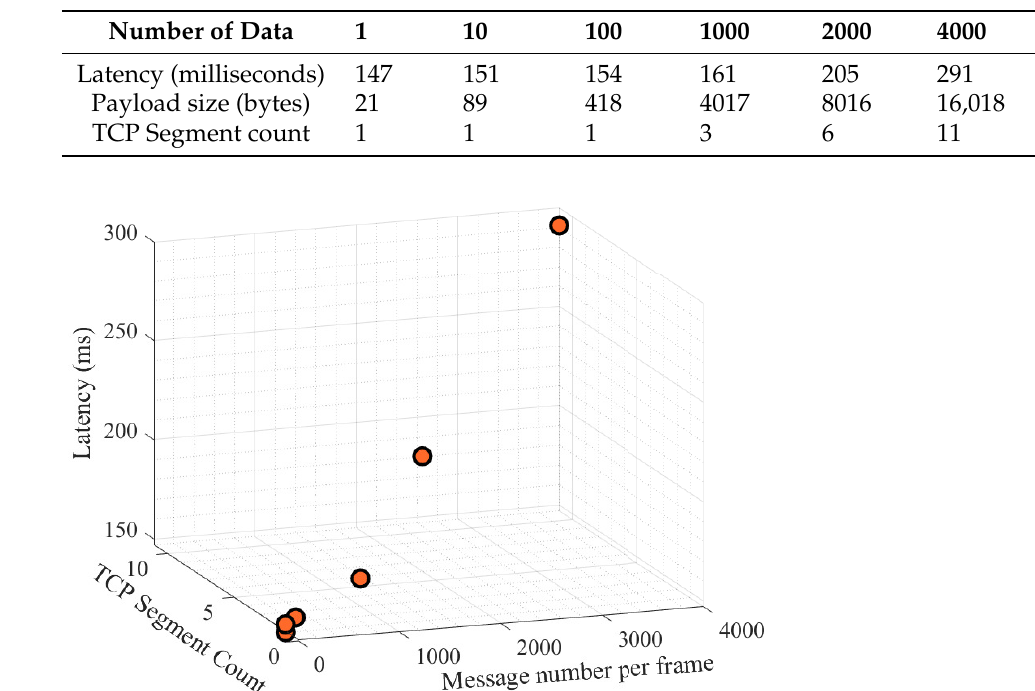
Table 4. Latency test results for various payload sizes.